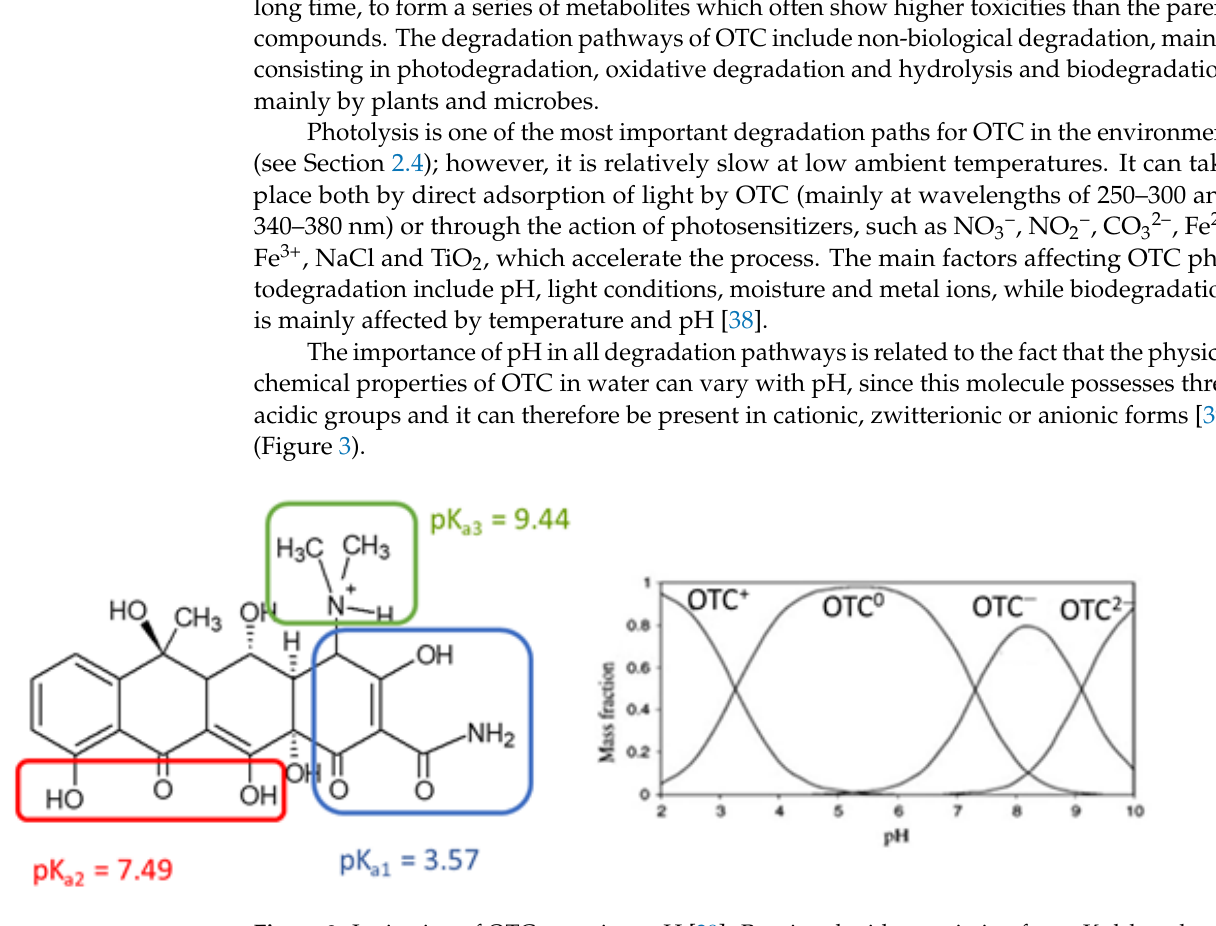
Figure 3. Ionization of OTC at various pH [39]. Reprinted with permission from: Kulshrestha, P.; Giese, R.F.; Aga, D.S. Investigating the Molecular Interactions of Oxytetracycline in Clay and Organic Matter: Insights on Factors Affecting Its Mobility in Soil. Environ. Sci. Technol. 2004 , 38 , 4097–4105. https://doi.org/10.1021/es034856q. Copyright 2004 American Chemical Society. OTC exists predominantly as a cation (OTC + ) below pH 3.3, when the dimethylammonium group is protonated (pK a1 = 3.57) as a zwitterion, resulting from the loss of a proton from the phenolic diketone moiety (pK a2 = 7.49) between pH 3.3 and 7.3, as a